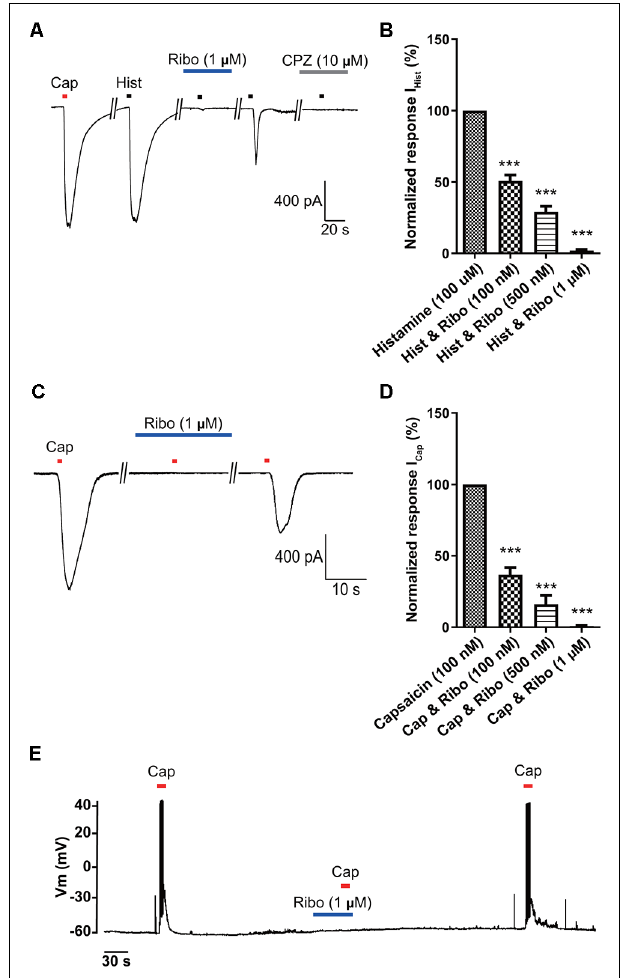
capsaicin-induced currents in small-sized dorsal root ganglion (DRG) neurons. (A) Inward currents were activated by capsaicin (Cap, 100 nM, 5 s or histamine (Hist, 100 µ M, 5 s) that was blocked by riboflavin (1 µ M, 5 min) or capsazepine (CPZ, 10 µ M, 5 min) at the holding potential of − 60 mV in small-sized DRG neurons. (B) Summary of I Hist inhibition by riboflavin relative to the other I Hist (*** p < 0.001, n = 5, LSD’s post hoc after one-way ANOVA). (C) Capsaicin-induced inward currents were blocked by riboflavin (1 µ M) at the holding potential of − 60 mV in small-sized DRG neurons. (D) Summary of I Cap inhibition by riboflavin relative to the others I Cap . Results are presented as the mean ± SEM (*** p < 0.001, n = 5, LSD’s post hoc after one-way ANOVA). (E) Current-clamp recording showing the blockade of capsaicin (Cap, 200 nM)-induced action potentials by riboflavin (1 µ M). Cap,